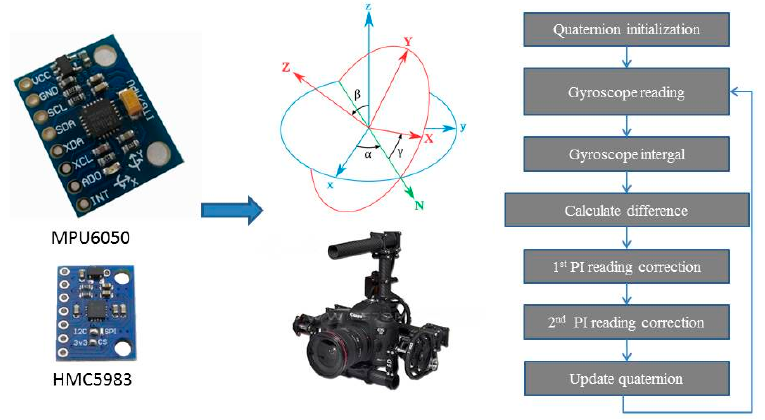
Figure 5. AHRS data fusion steps.